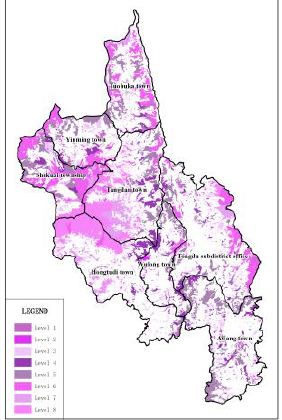
Figure 4. Grassland quality classification map of